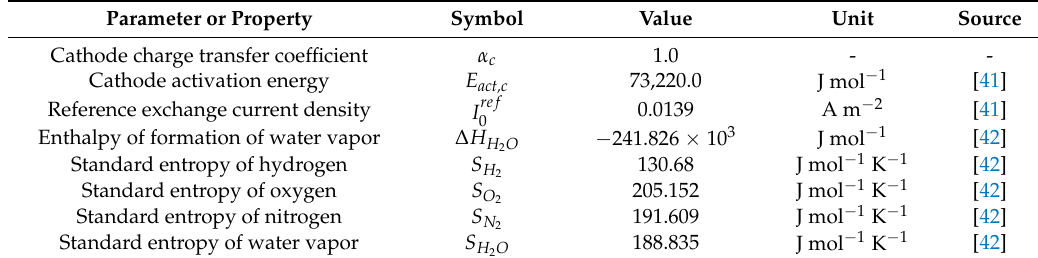
Table 5. Electrochemical parameters and properties.